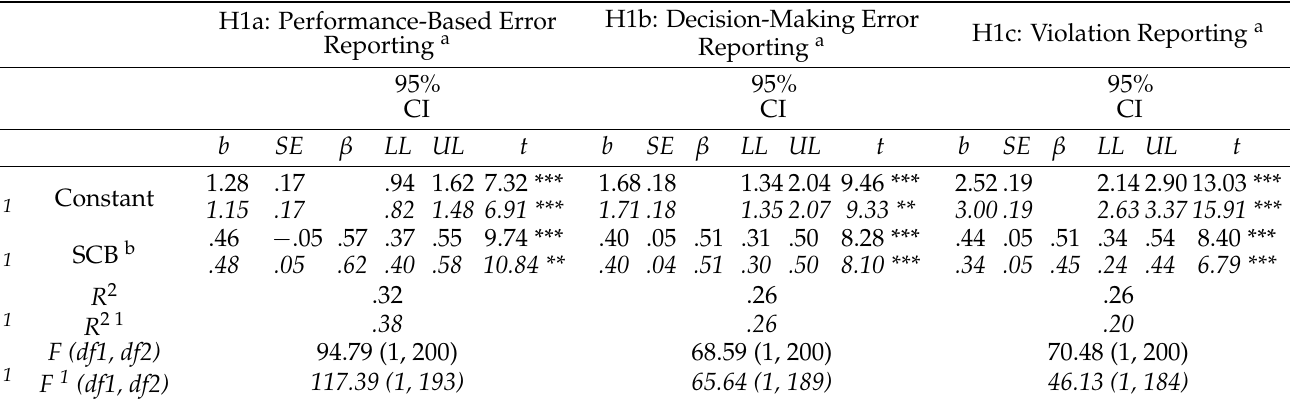
Table 2. SCB predicting reporting